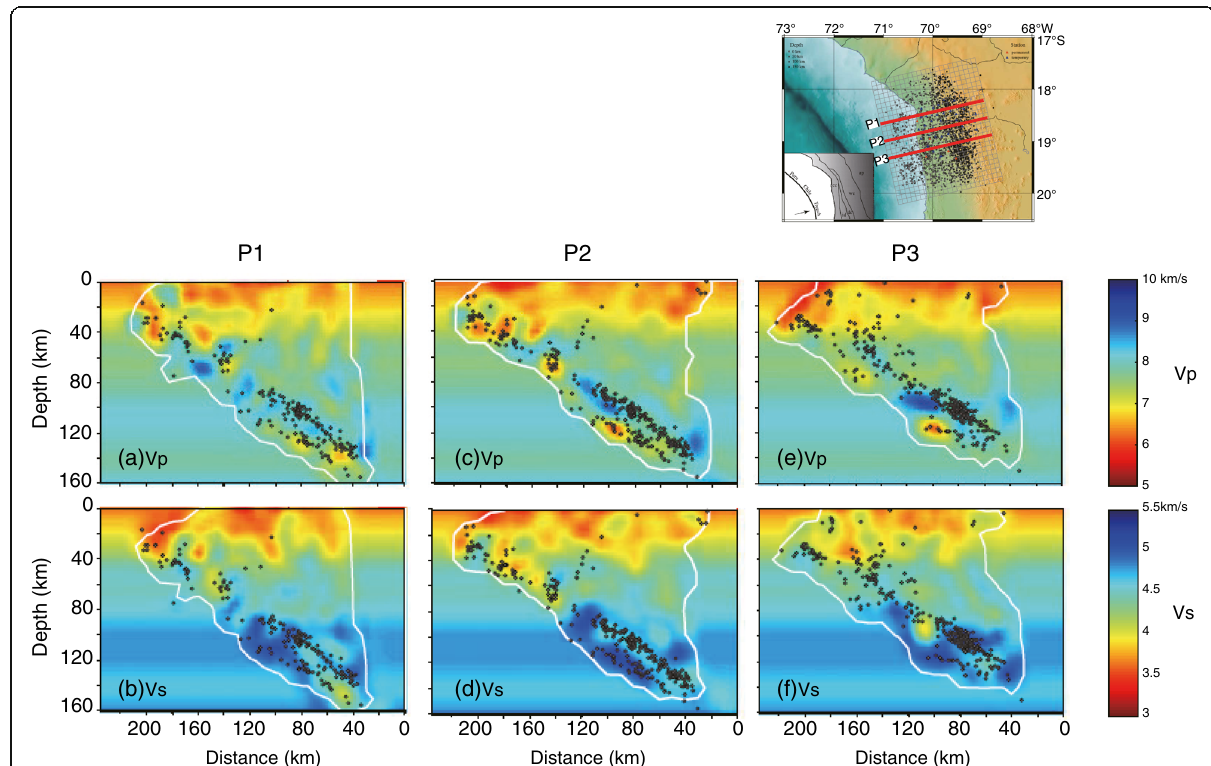
Fig. 21 Seismic velocity structure along the lower seismic plane under northern Chile. Shown are across-arc vertical cross-sections of a – c P-wave velocity and d – f S-wave velocity beneath northern Chile. P- and S-wave velocities along three lines in the inset map are indicated by the color scales to the right. Earthquakes within a 20 km-wide section are plotted as dots. White lines denote the limit of resolution where the derivative weight sum is more than 10. (After Dorbath et al.